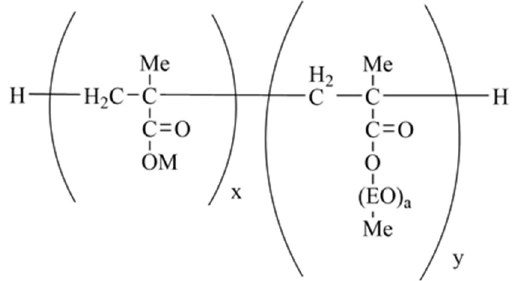
Figure 4. The molecular formula of polycarboxylic acid.